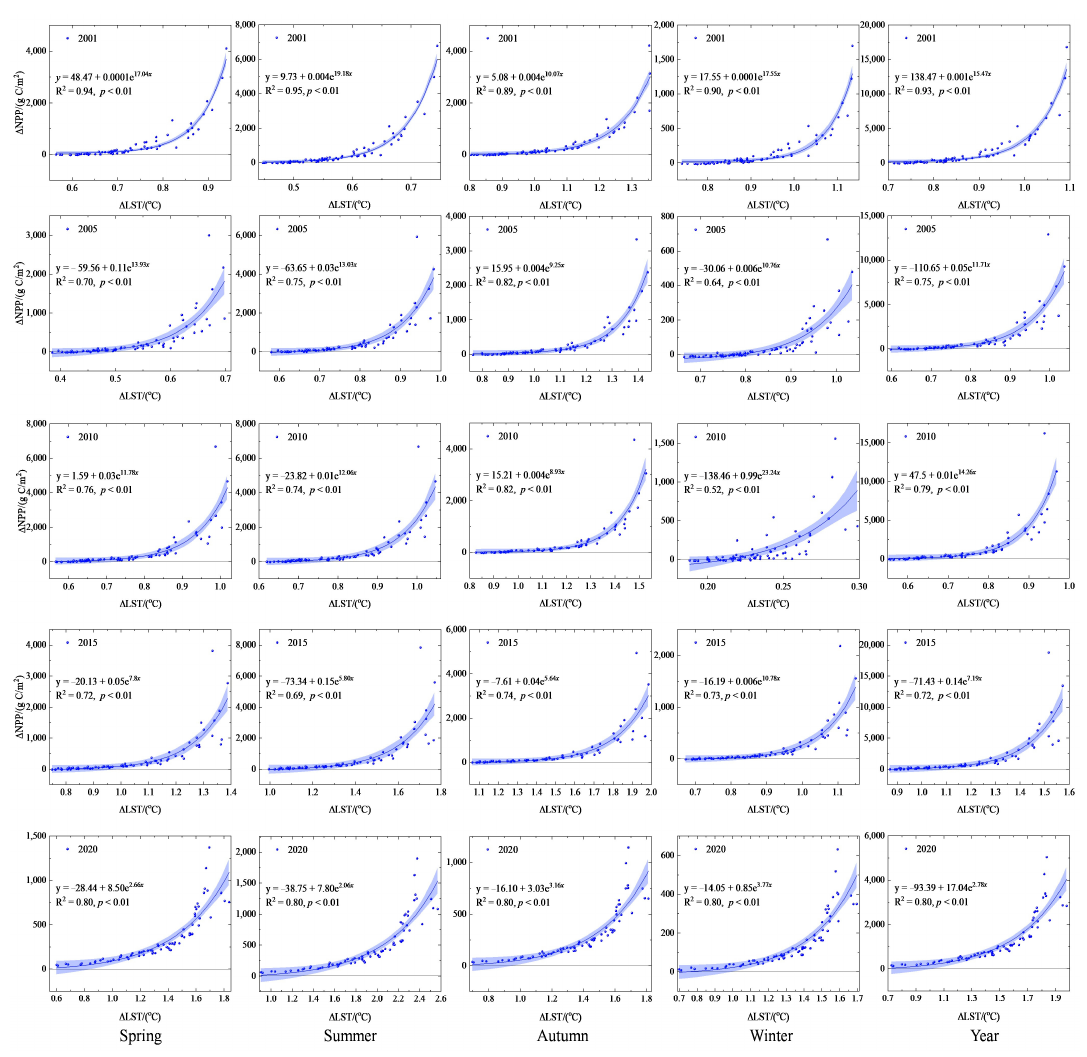
Figure 5. The impact of annual mean LST on NPP during 2001 −